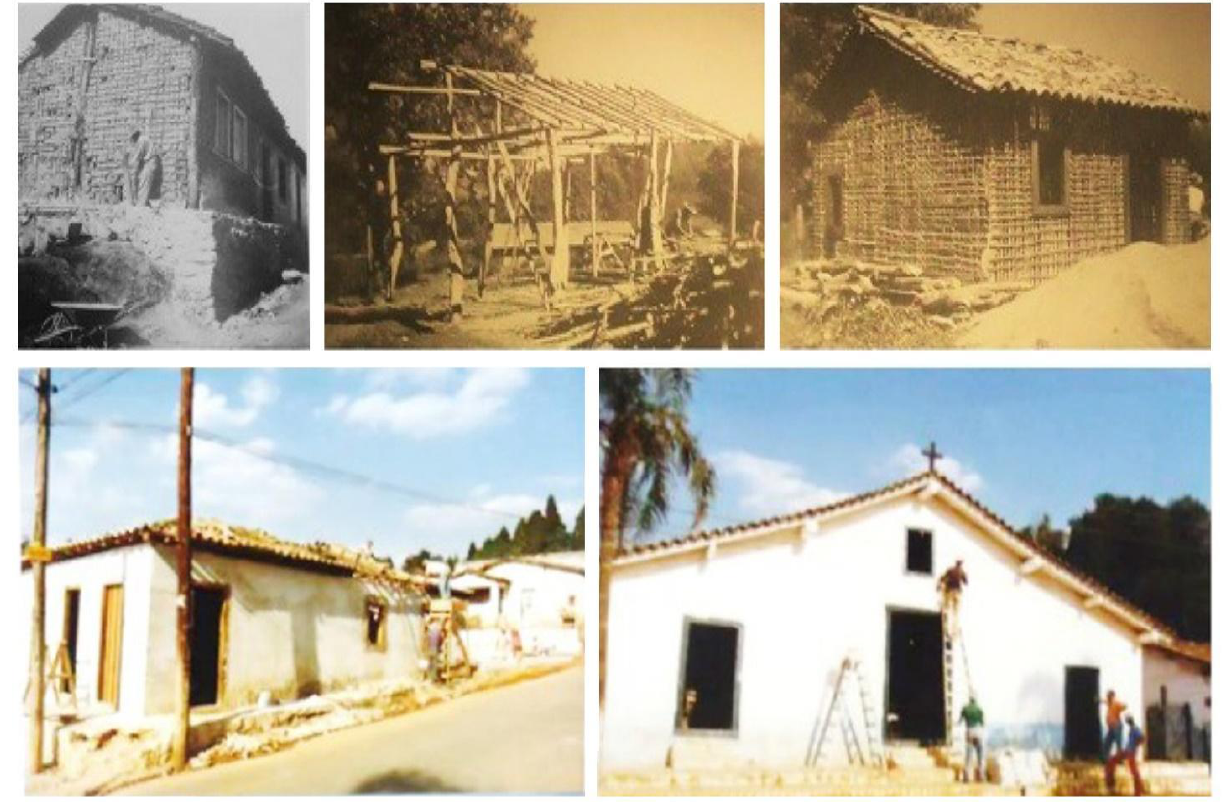
Figure 5. Different stages of renovation of the Apericube